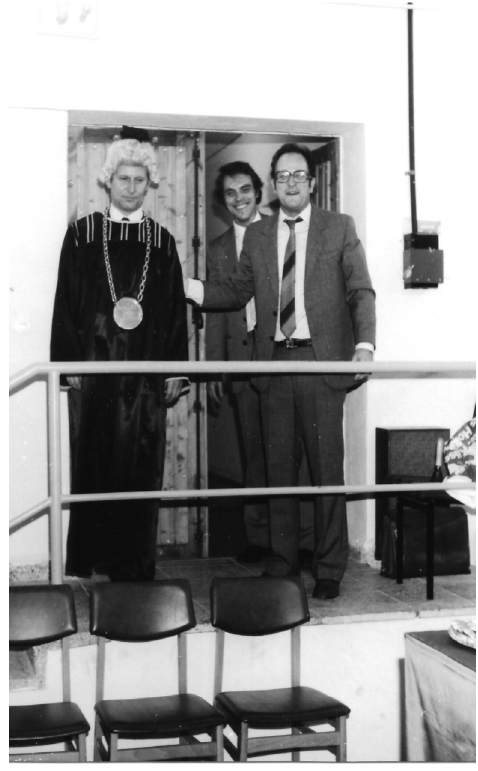
Figure 14. The party at Vollstaedt’s habilitation (left, central Mueller, right Waesch).